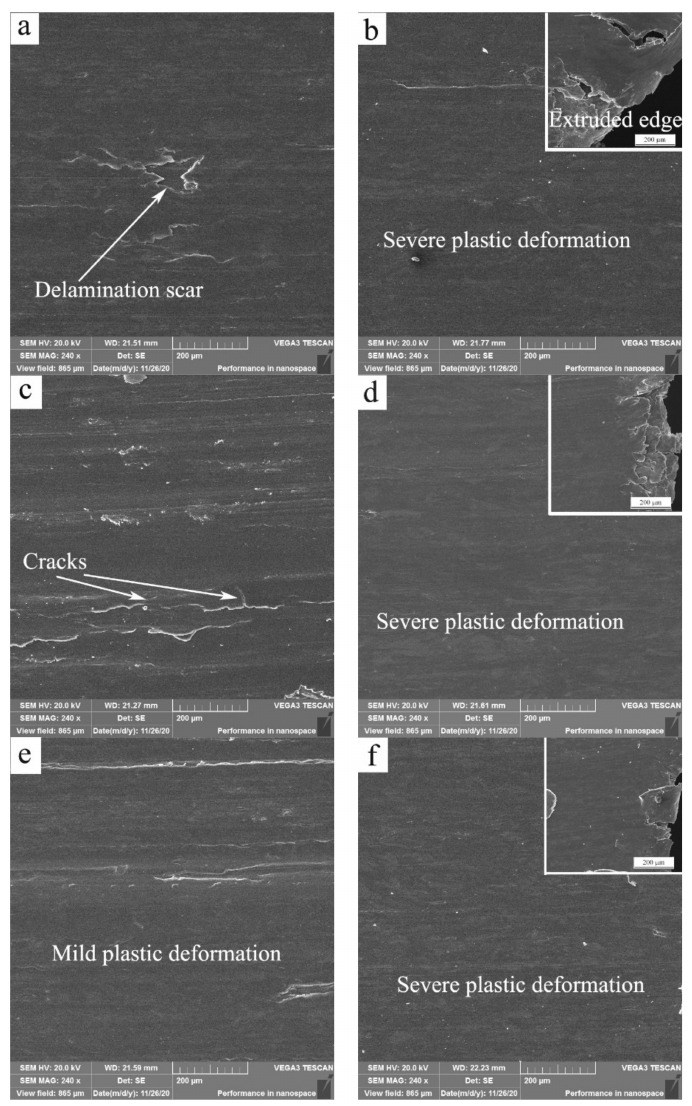
Figure 4. SEM images of worn surfaces at 100 ◦ C ( a , b ), 150 ◦ C ( c , d ) and 200 ◦ C ( e , f ) under different loads: ( a ) 60 N, ( b ) 80 N, ( c ) 20 N, ( d ) 50 N, ( e ) 20 N, ( f ) 40